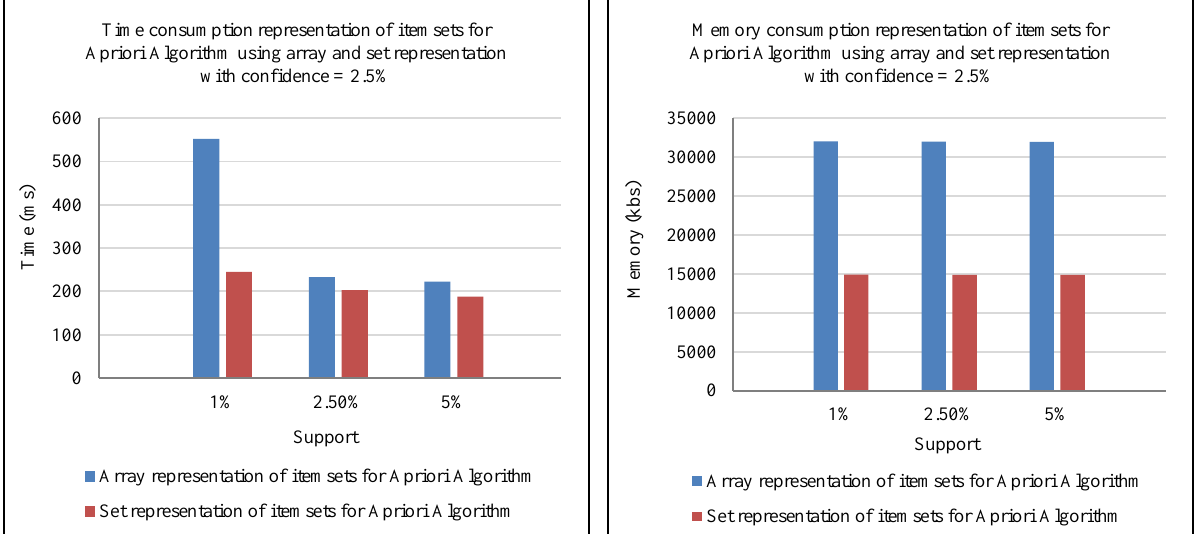
Figure 7. Time and memory consumption of Apriori Algorithm using set and array representation with confidence=